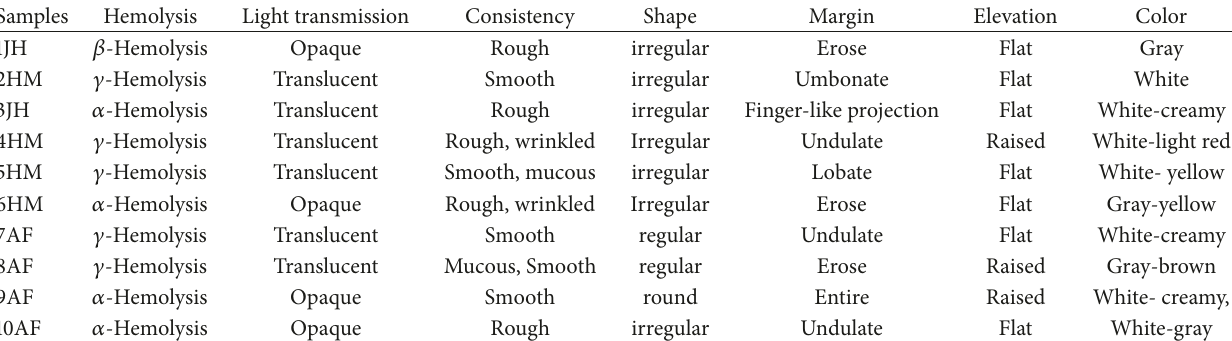
Table 2: Colony morphology of the ten haplotypes isolated from Jordanian hot